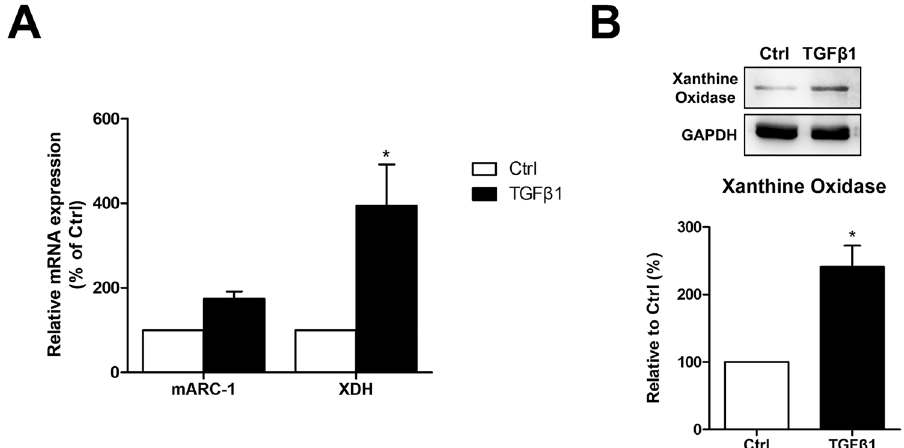
Figure 6. Nitrite reductase activity in keratocyte was measured in keratocytes using mitochondrial amidoxime reducing component 1 (mARC1), xanthine dehydrogenase (XDH) and xanthine oxidase. The mRNA expression level of mARC1 and xanthine dehydrogenase was measured with quantitative polymerase chain reaction while the protein level of xanthine oxidase was measured with western blot. TGFβ1 (10 ng/mL) stimulation increased xanthine dehydrogenase gene expression ( A ) and xanthine oxidase protein level ( B ) significantly in keratocytes. *p < 0.05.